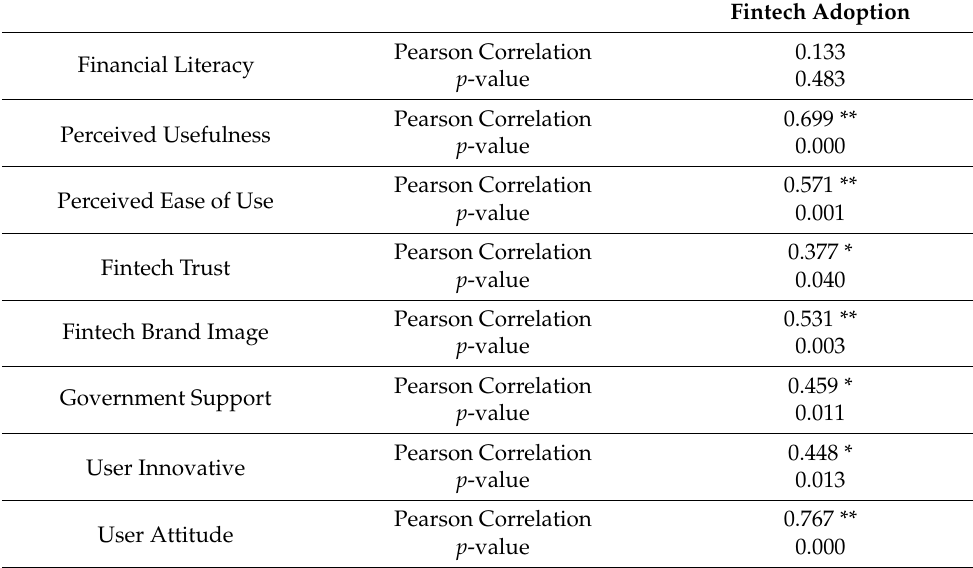
Table 13. Pearson correlation.